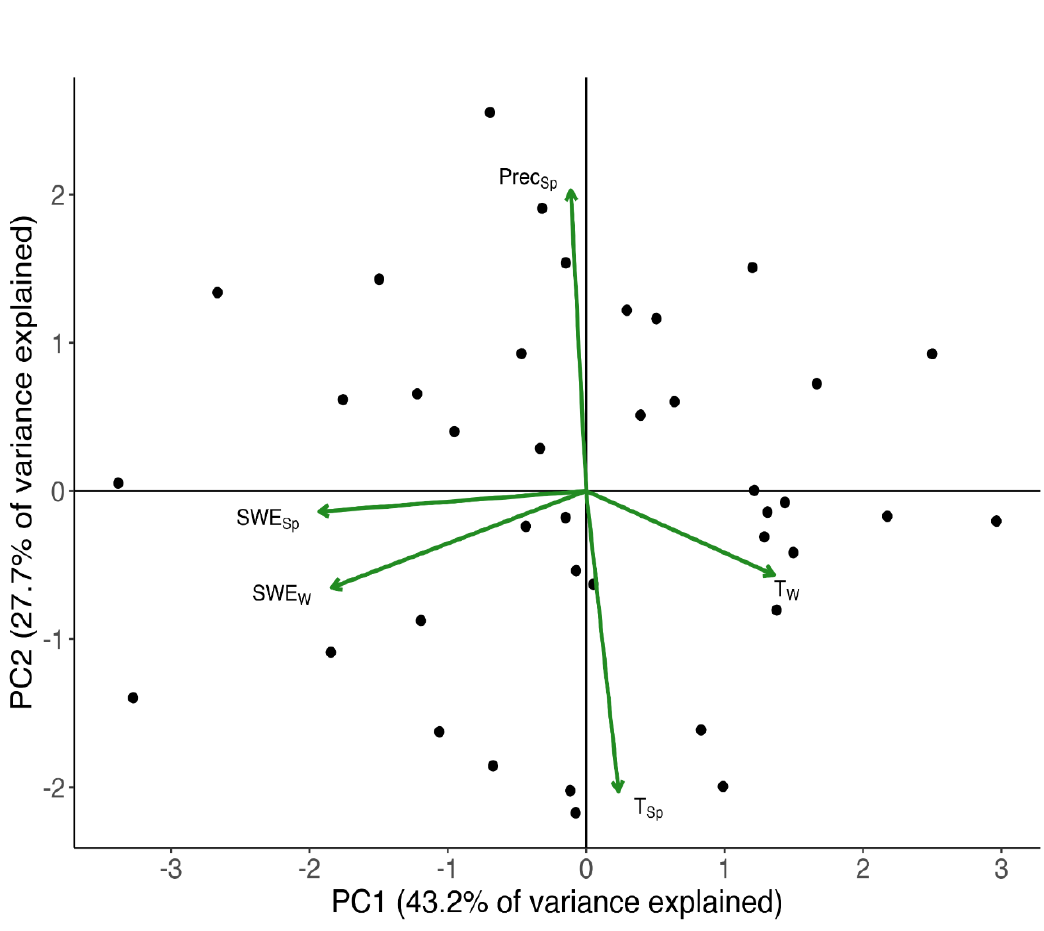
Figure S1. Graphical visualisation of the first two principal components of our principal component analysis. The points represent the scores over the two axes, while the arrows represent the loadings of the five environmental variables. The first principal component explained 43.2% of the variance in the data, while the second principal component explained 27.7%. T Sp is the average minimum daily spring temperature, T W is the average minimum daily winter temperature, Prec Sp is the total precipitation in spring, SWE Sp is the total spring snow water equivalent and SWE W is the total winter snow water